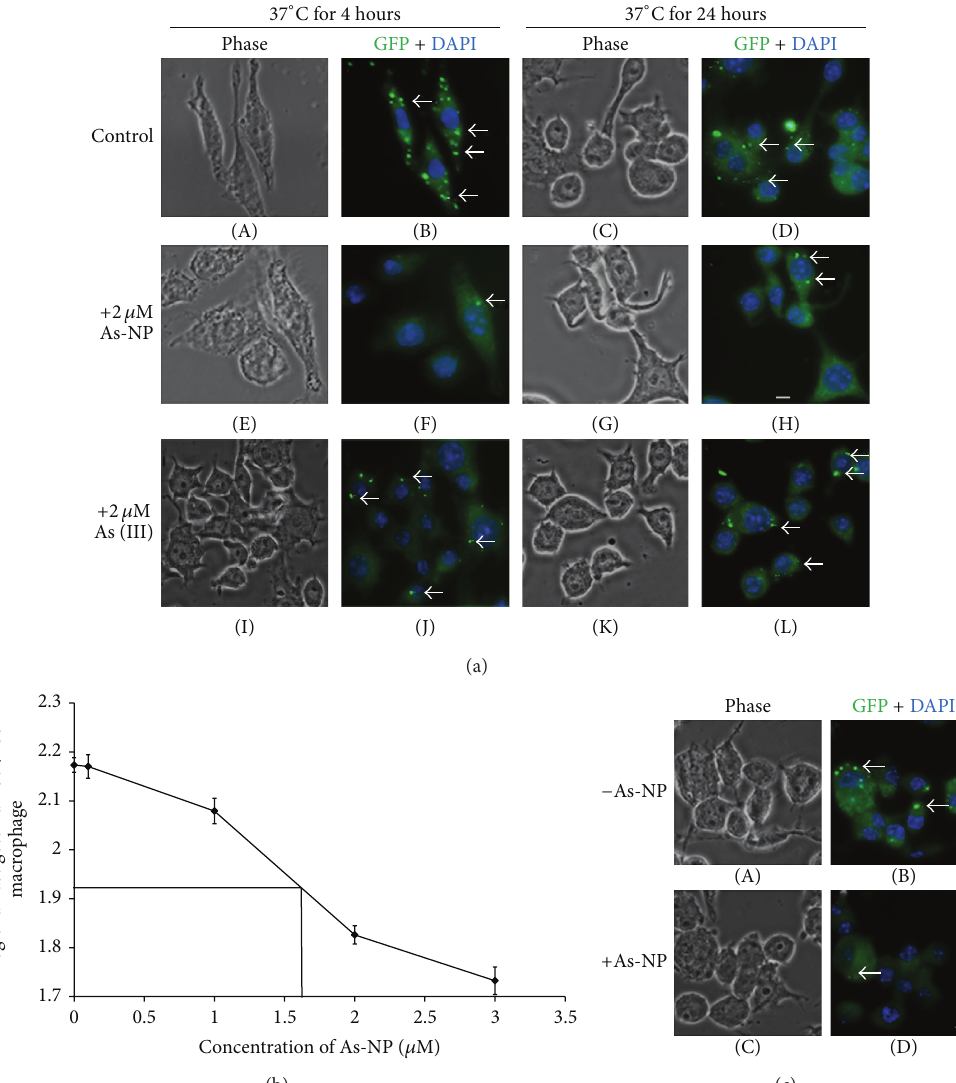
Figure 3: As-NPs treated parasites show reduced infectivity in vitro . (a) Infection of RAW 264.7 macrophages with Leishmania promastigote was carried out as described in Section 2. Leishmania infected macrophages were incubated at 37 ∘ C for 4 hours (panels (A), (B), (E), (F), (I), and (J)) and 24 hours (panels (C), (D), (G), (H), (K), and (L)) in absence (panels (A), (B), (C), and (D)) and in presence (panels (E), (F), (G), and (H)) of As-NPs (2 𝜇 M) and in presence of 2.0 𝜇 M As (III) (panels (I), (J), (K), and (L)) as described earlier, after which cells were prepared for fluorescence microscopy. Pictures were taken in phase (panels (A), (C), (E), (G), (I), and (K)), GFP filter (green), and DAPI filter (blue). The GFP and DAPI images were merged (panels (B), (D), (F), (H), (J), and (L)). Arrows indicate internalized parasites. Scale bar indicates 2 𝜇 m. These images only represent one of multiple independent sets. (b) Determination of IC 50 value from the plot of log (internalized cells or amastigotes per 100 infected macrophages) was obtained after 24 hours of incubation with indicated concentrations of As-NPs. The error bars indicate SEM. (c) Treatment with As-NPs reduced macrophage attached Leishmania parasites. Attachment of Leishmania parasite on macrophages was determined by incubating the Leishmania infected macrophages at 4 ∘ C for 4 hours in absence (panels (A) and (B)) and presence (panels (C) and (D)) of As-NPs. Fluorescent pictures were captured in phase (panels (A) and (C)), GFP filter (green), and DAPI filter (blue). Panels (C) and (D) show merged images captured by GFP and DAPI filters (panels (B) and (D)). Arrows indicate macrophage attached parasites. These images only represent one of multiple independent sets. Scale bar indicates 2 𝜇